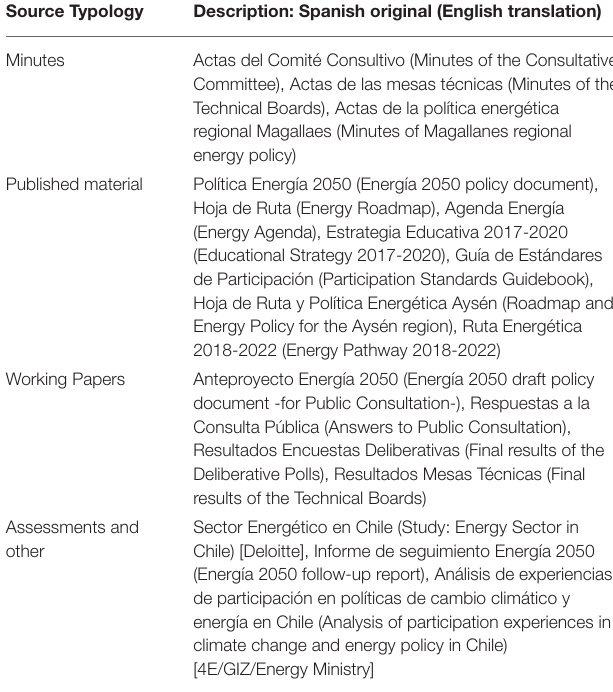
TABLE 2 | Secondary sources by